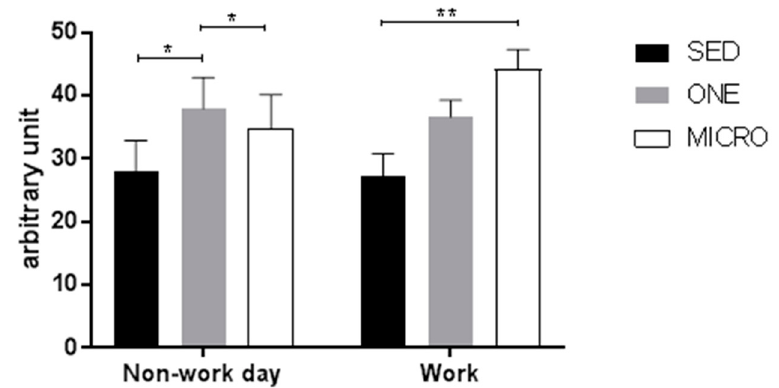
Figure 1. Visual analog scale representing the perception of the challenges associated with the conditions. At the end of each intervention or control day participants filled out online 100 mm visual analog scales (VAS) designed to capture their perception of the study condition. The VAS addressed the following question “ Please indicate on the scale how challenging you found the day. ” The anchors for this question were “ Extremely Easy ” and “ Extremely Challenging. ” SED, indicates the sedentary condition; ONE, indicates the one-bout intervention; MICRO, indicates the microbouts intervention. * p < 0.05, ** p < 0.01 vs. sedentary control.